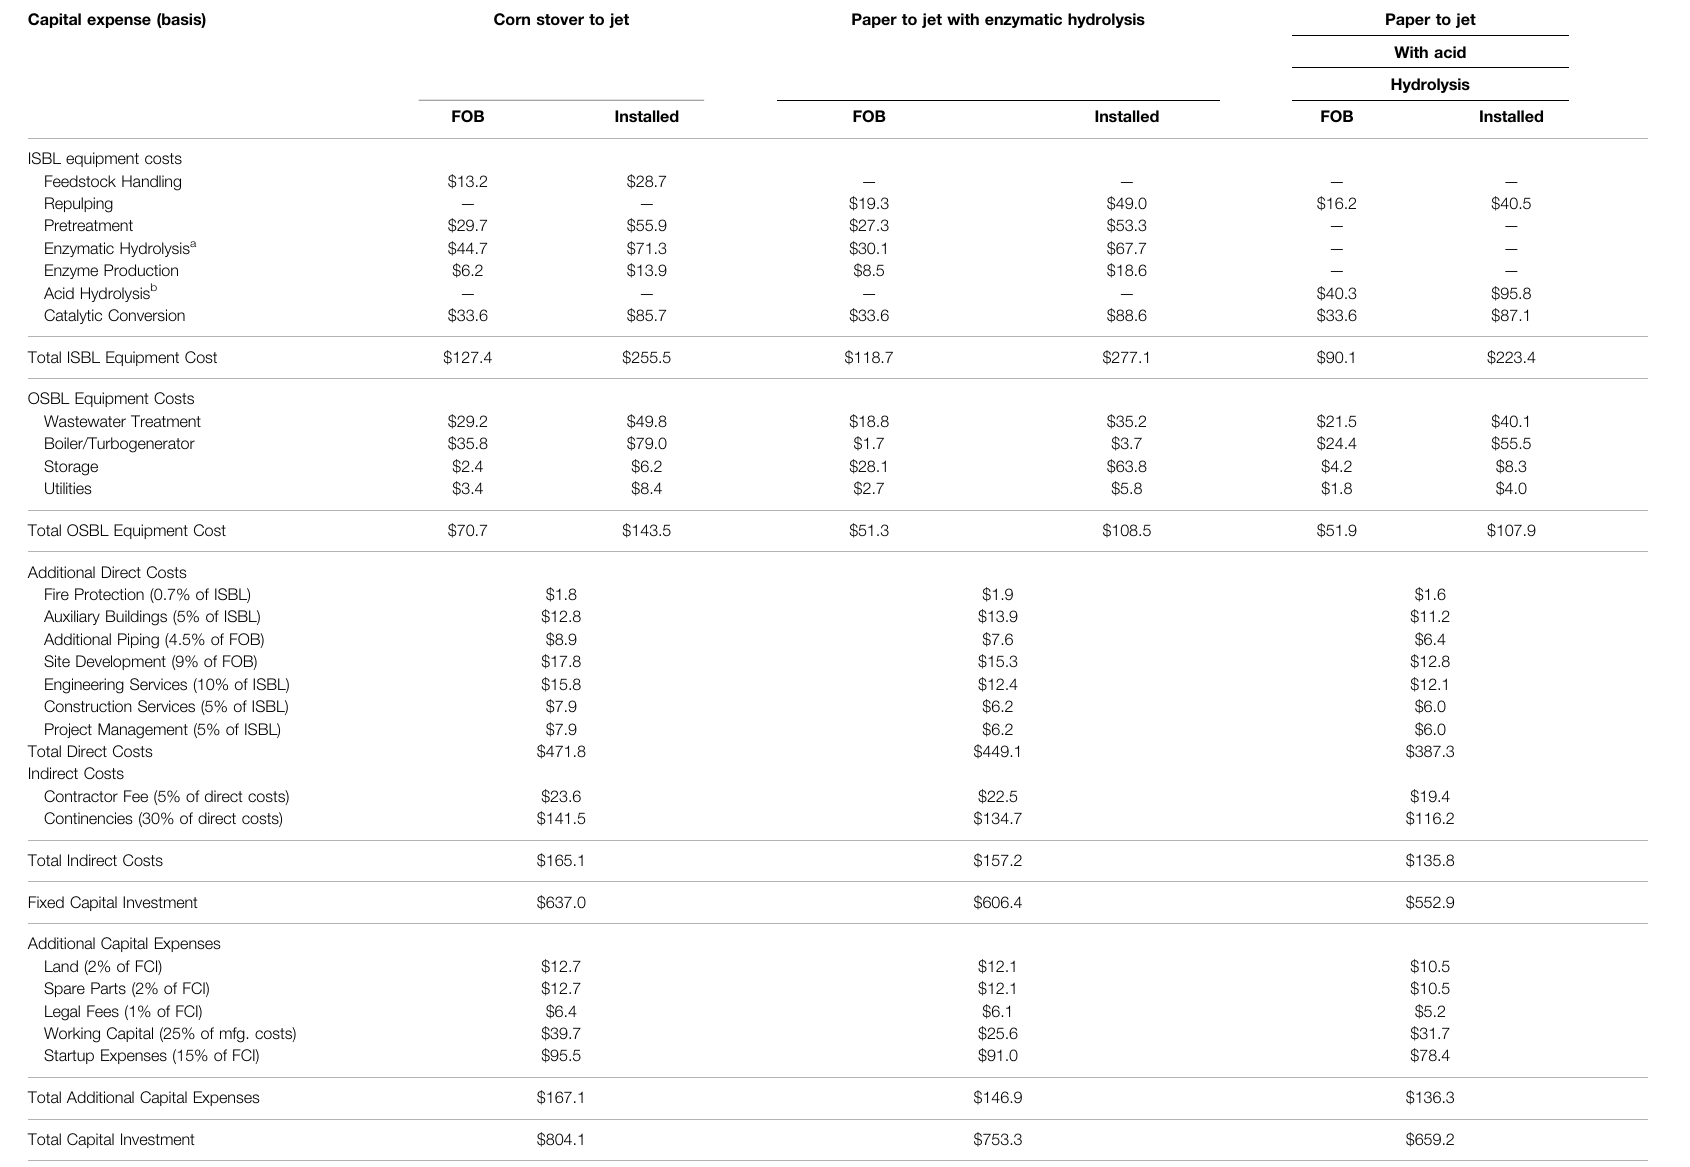
TABLE 3 | Capital cost estimates for corn stover to jet fuel, recycle paper to jet fuel with enzymatic hydrolysis, and recycle paper to jet fuel with acid hydrolysis in million USD